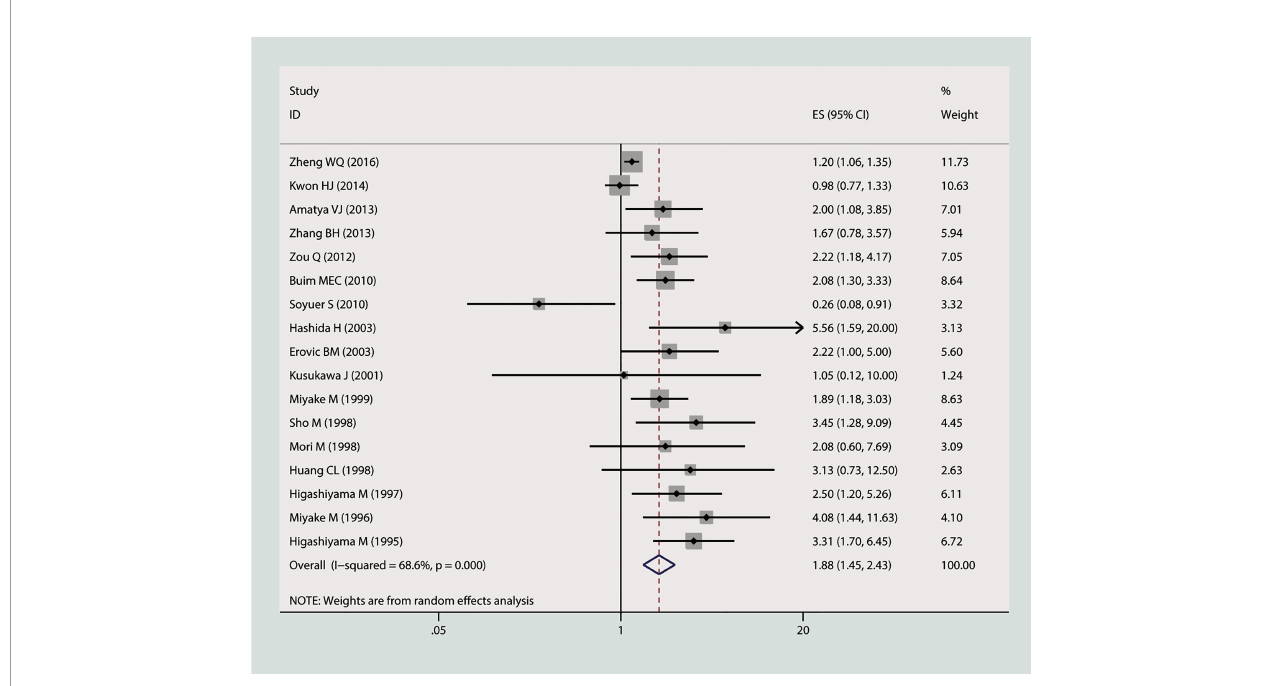
FIGURE 2 | The connection between CD9 expression and overall survival (OS) in solid tumors.